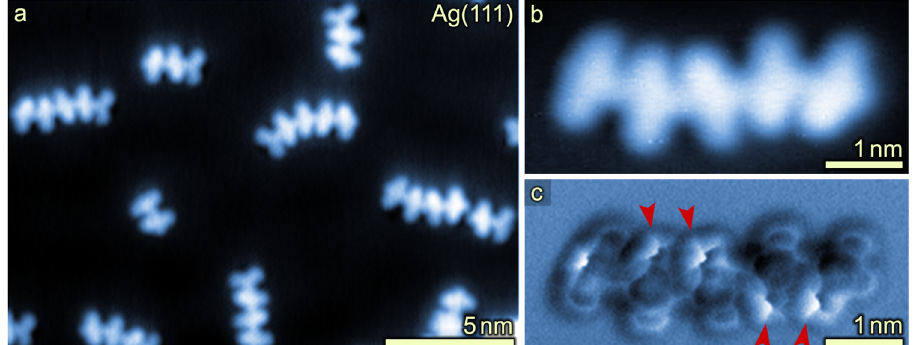
Fig. 4 Head-to-tail coupling of 1 on Ag(111) held at 520 K. a Overview STM image after deposition of 1 onto a Ag(111) substrate held at 520 K shows polymerization towards one-dimensional molecular chains. ( b ) STM and ( c ) bond-resolved AFM image of a pentamer recorded with a CO-functionalized tip shows formation of imidazole rings between the monomer units — analogous to the coupling observed on Au(111). Red arrows highlight brightly imaged phenyl rings bending upwards due to steric repulsion. The terminal cyano group of the pentamer shown in b and c is cleaved off. Such loss of – CN has repeatedly been observed on Ag(111). Scan parameters: ( a ), ( b ) V S = 100 mV, I = 10 pA, ( c ) V S = 0 V, A OSC = 80 pm, constant height. Frequency shift range: ( c ) − 4.5 to 1.0 Hz.